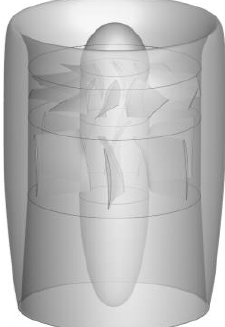
Figure 1. Geometry of the 150 ducted fan.